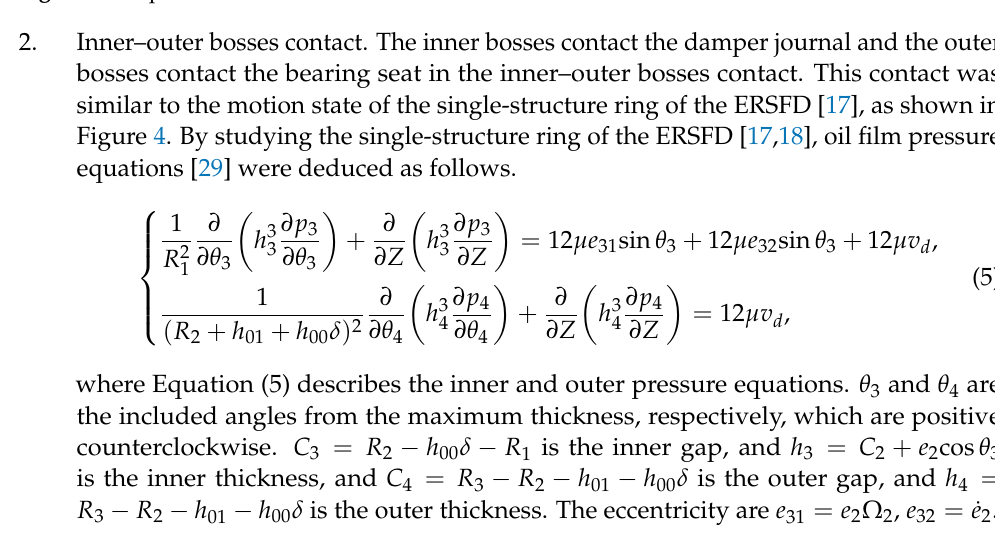
Figure 3. Suspension.